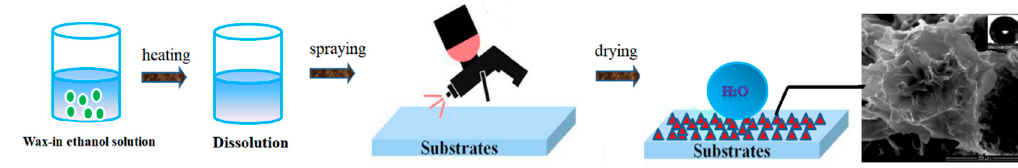
Figure 1. Illustration for preparation of a non-wettable surface.